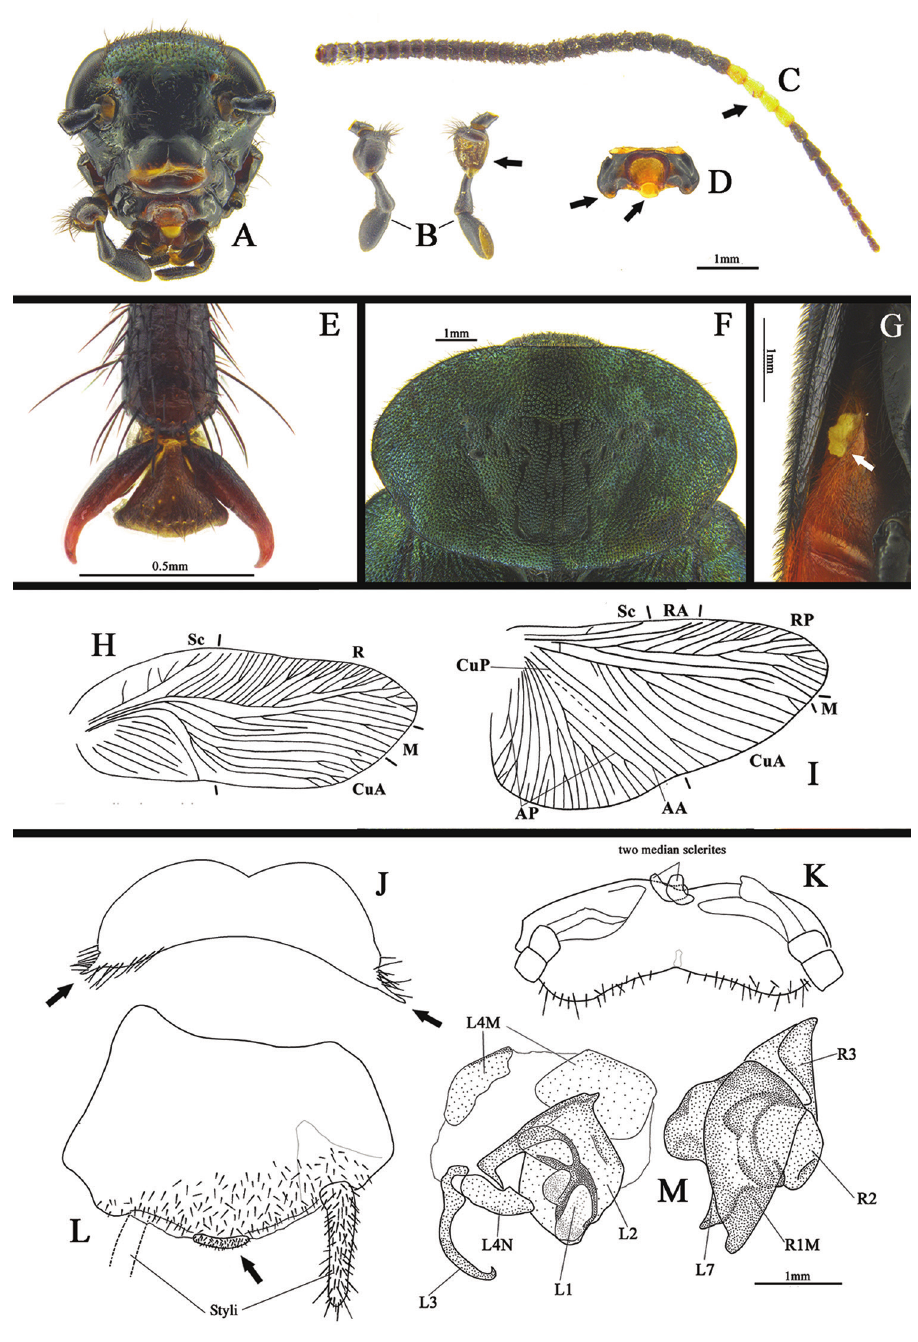
Figure 1. A–M Features of male Eucorydia Hebard A head B maxillary palpus C antenna D labrum E arolia F pronotum G eversible gland on abdomen H venation of tegmen I venation of wing J T8, dorsal K supra-anal plate, ventral L subgenital plate, ventral M genitalia,